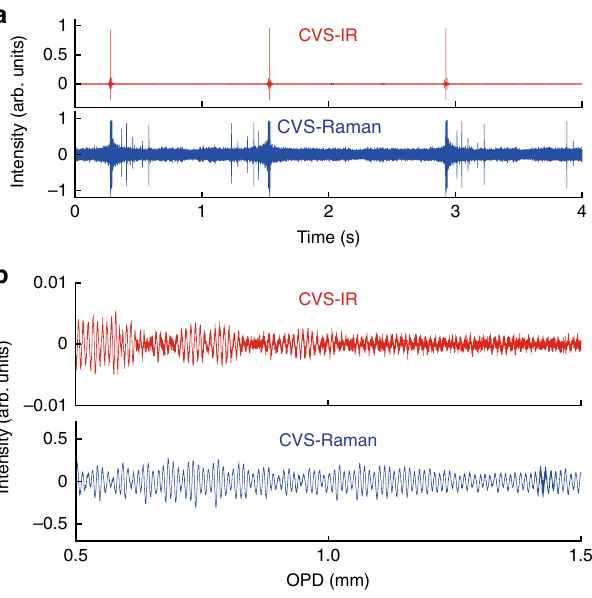
Fig. 2 CVS interferograms of toluene. a The upper and lower panels show the sequential interferograms measured by CVS-IR and CVS-Raman spectroscopy, respectively. b Magni fi ed 15-averaged CVS-IR and CVS- Raman interferograms plotted as a function of the